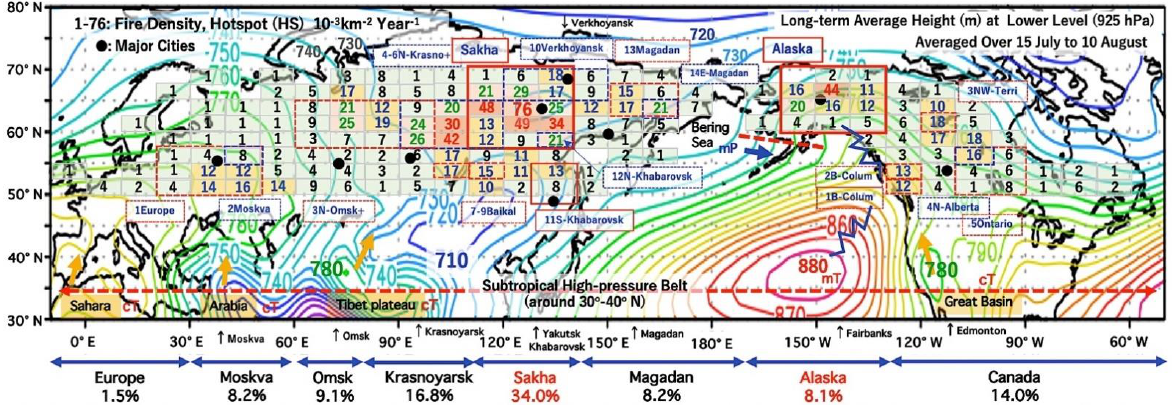
Figure 1. Map of part of the northe r n hemisphere (30° – 80° N, − 10° – 310° E). The Arctic study region (50° – 70° N, 0° – 360° E) was divided into 288 areas (2.5° N × 10° E), showing their fire density (hotspot (HS) 10 −3 km −2 Year −1 ). The area of each cell is calculated geometrically and does not consider land- scapes such as seas and mountains. The fire density of each cell is indicated by the numbers 1 to 75 (smaller than 1 is not shown). Eight wide area names by longitude (20° – 80° E)) are shown at the bottom of the figure such as “Europe”, “Moskva” , etc. Two rectangles with a red solid line show two major study regions of Sakha and Alaska. Rectangles with a red or blue dotted line show other study areas and their names are found near them, such as “3N - Omsk+”. The first number in the name is given in order from the west side and used in Tables 1 and 2, such as “E2.Moskva” . The only exception area is “11S - Khabarovsk” , with a red solid line, analyzed in our past paper [30]. Based on those area names, abbreviatations in Tables 1 and 2 are created according to their respec- tive abbreviation formats. Major cities are indicated by black circles and their names are shown at the bottom of the figure. The base map is the lower air (925 hPa) weather map (long-term average map for 74 years from 1948) obtained from the NCEP/NCAR 40-year reanalysis data. Table 1. Top five active fires in Sakha and other active fires in Eurasia. Name 1,2